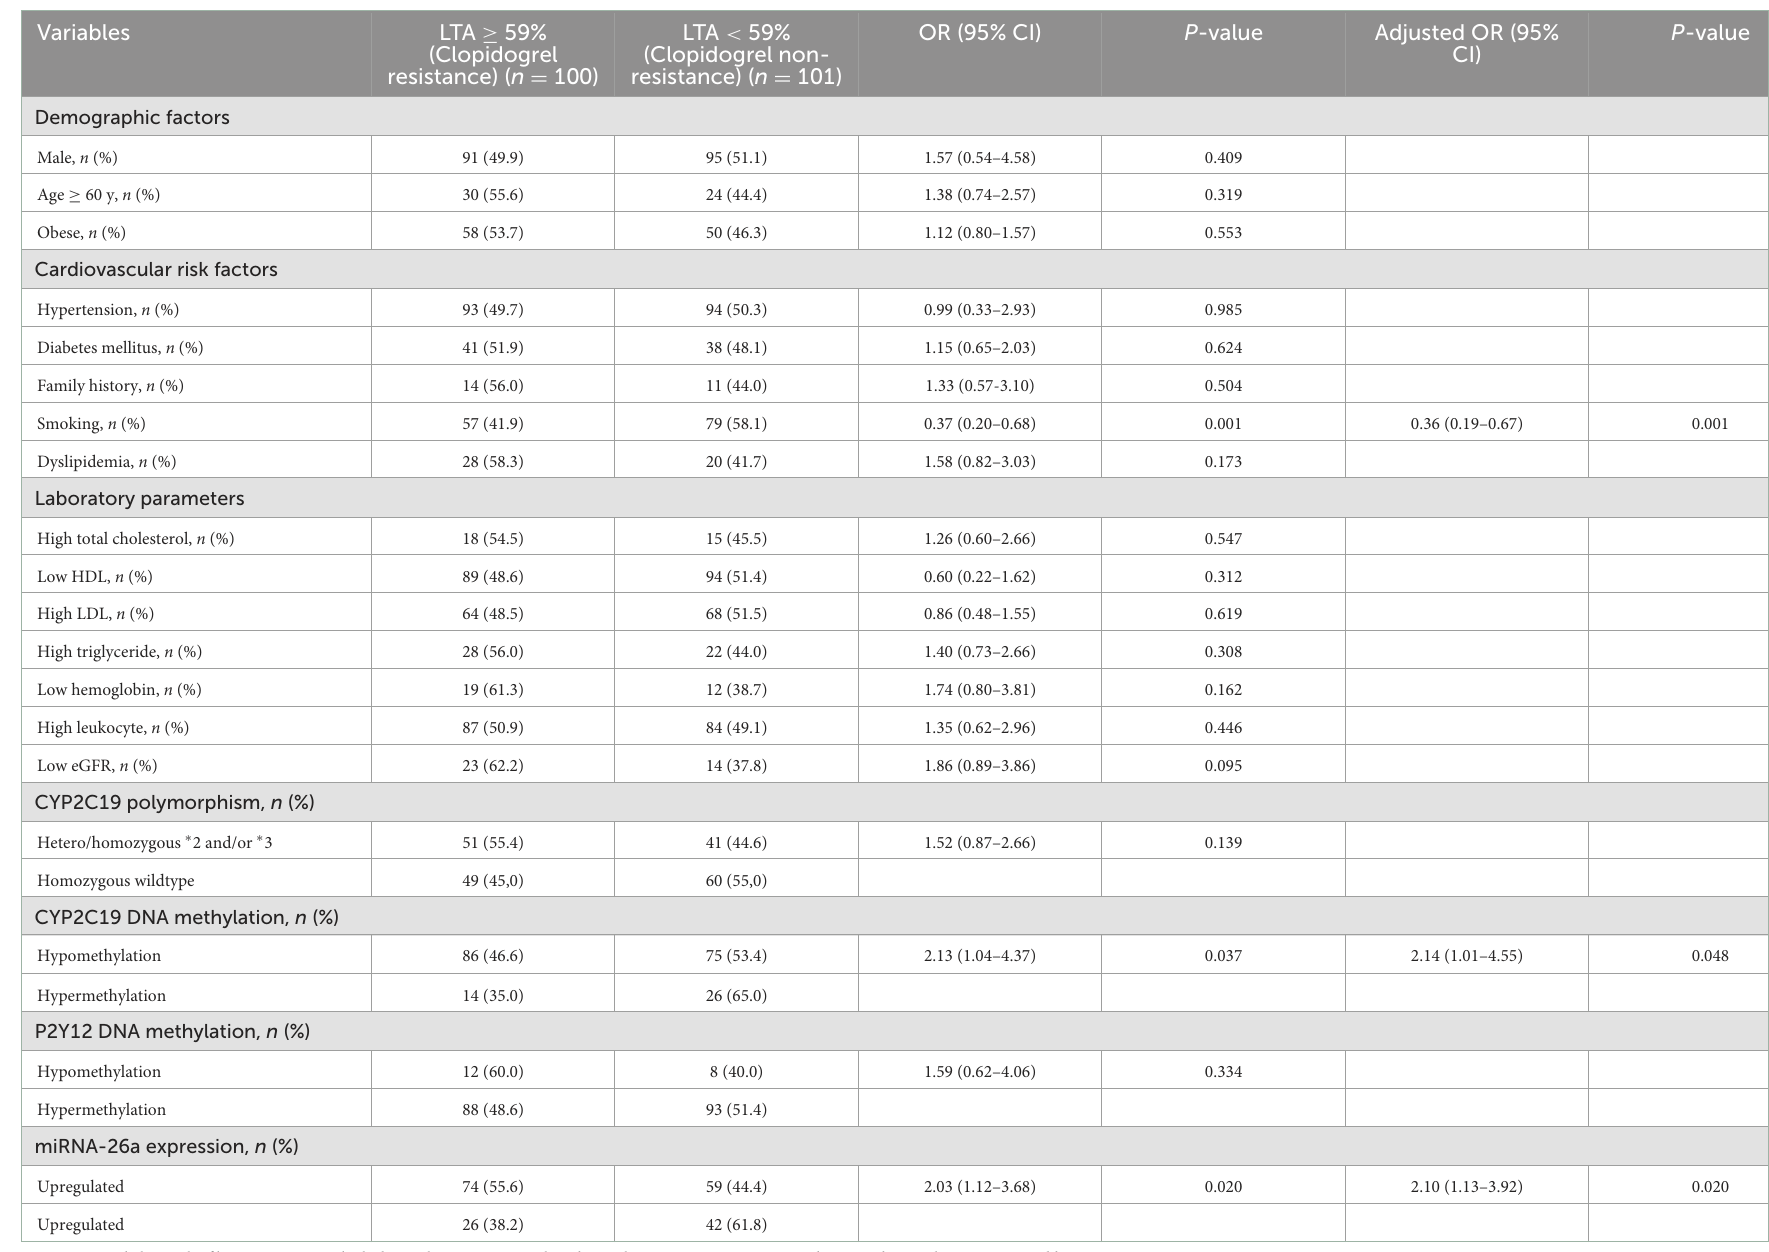
TABLE 4 The association between several factors and clopidogrel